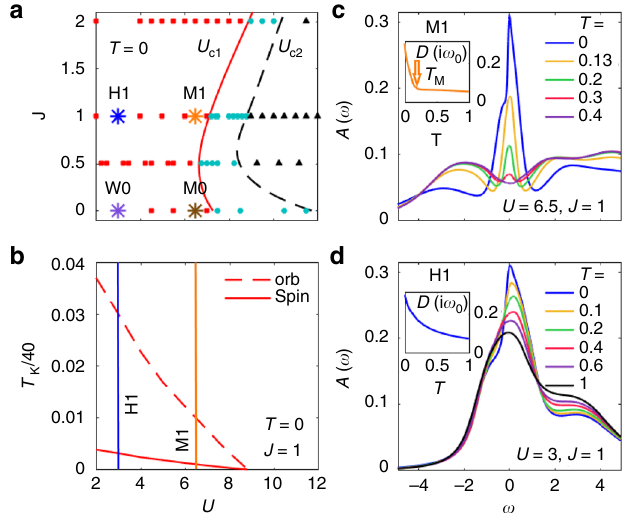
Fig. 5 Disentangling features of Mott and Hund physics in a DMFT + NRG study of the 3HHM: ( a ) phase diagram, ( b ) Kondo temperatures, and ( c , d ) LDOS A ( ω ). a The T = 0 phase diagram (cf. Fig. 5 of ref. 10 ) reveals three phases in the J – U -plane: a metallic phase (red squares), a coexistence region (blue circles), and an insulating phase (black triangles), separated by two-phase transition lines U c 1 (solid red curve), and U c 2 (dashed black curve), respectively. In panels ( c , d ) and also in Fig. 6 we focus on four parameter combinations, indicated in ( a ) by colored asterisks: two Mott systems with U = 6.5 near the U c 1 phase transition line, with J = 1 (M1) or J = 0 (M0); and two systems with U = 3 far from the transition and deep in the metallic state, a Hund system with J = 1 (H1) and a weakly correlated system with J = 0 (W0). b The Kondo temperatures, here shown for J = 1 (cf. Fig. 12 of ref. 10 ) are extracted from frequency-dependent ð T orb Þ corresponds to the susceptibilities at T = 0, as de fi ned in ref. 9 . T spin K K screening of spin (orbital) degrees of freedom. Fermi liquid behavior sets in = 40 (cid:8) T cmp below the temperature scale T spin . Orange and blue vertical K spin lines mark the values of U used for M1 and H1, respectively. c , d The temperature dependence of the LDOS for M1 and H1, respectively. The (cid:5)